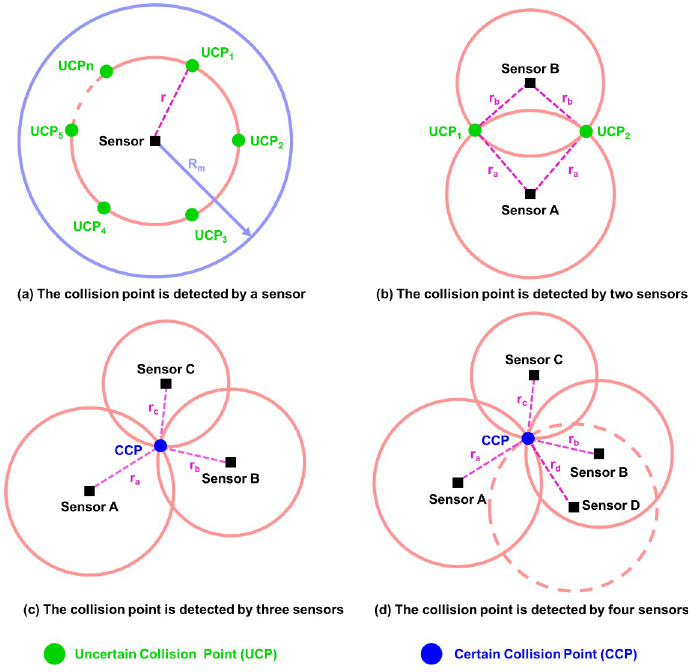
Fig 2. The possible location of the collision point when the point is detected by (a) a sensor, (b) two sensors, (c) three sensors and (d) four sensors at the same time,